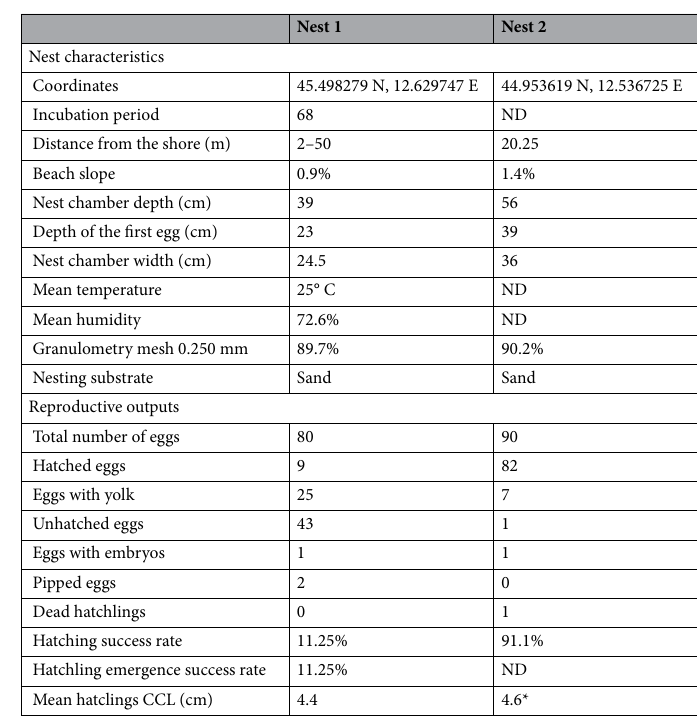
Table 1. Nest characteristics and reproductive output of the two nests. Nest 1 – Jesolo Lido, Nest 2 – Scano Boa. *Calculated only in 2 hatchlings